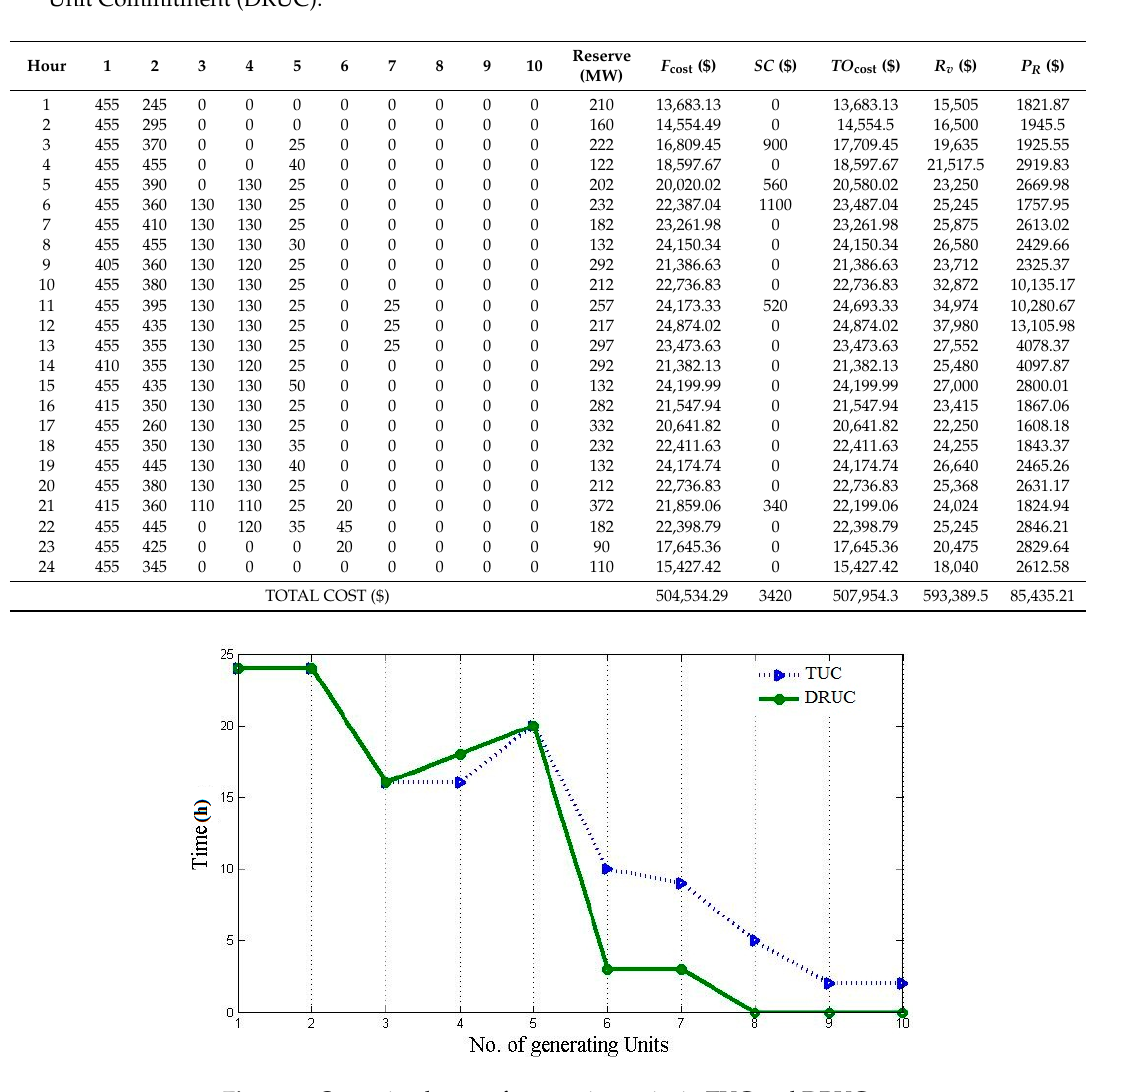
Figure 3. Operating hours of generating units in TUC and DRUC.